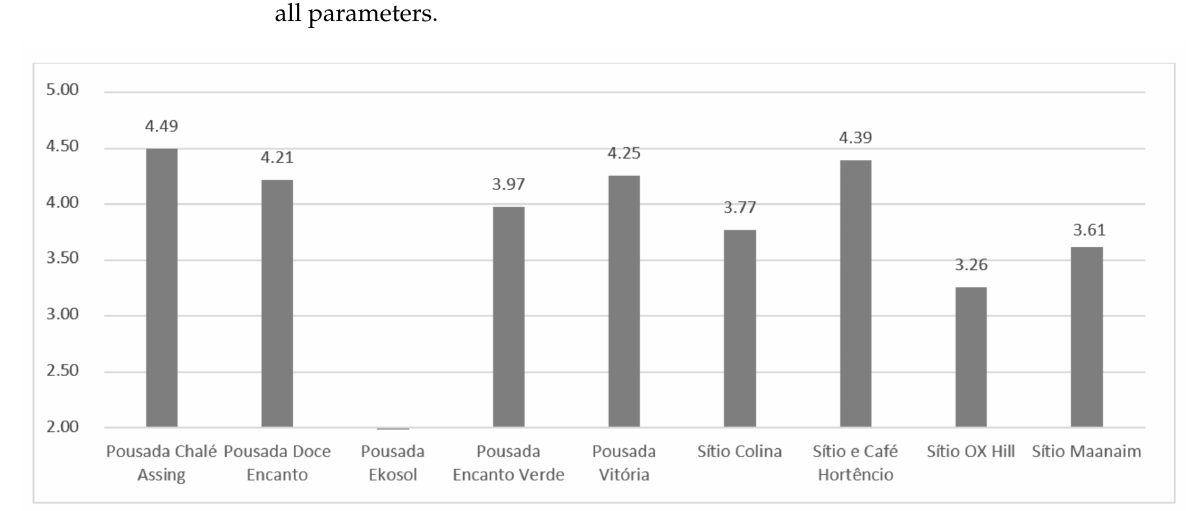
Figure 2. Final average of